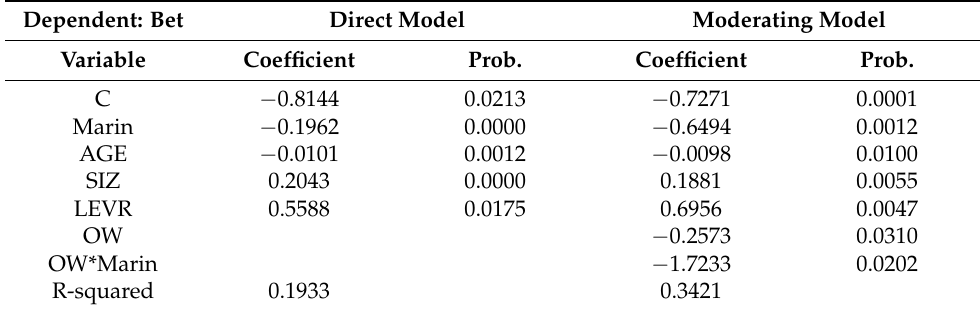
Table 7. Marketing investment and systemic risk: estimation